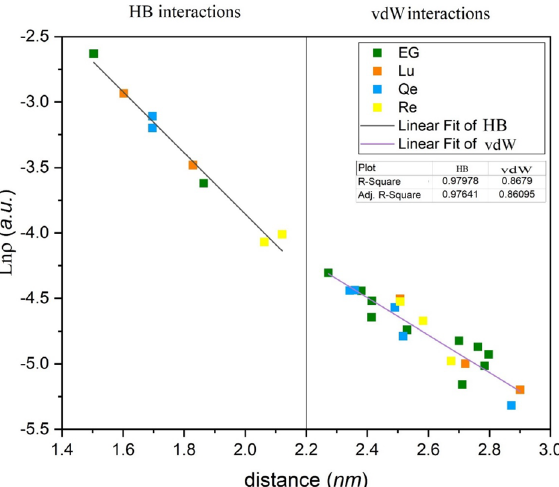
Figure 8. ln(ρ BCP ) (left: hydrogen bonds and rigth: van der Waals regions) as a function of intermolecular distance in the investigated complexes.